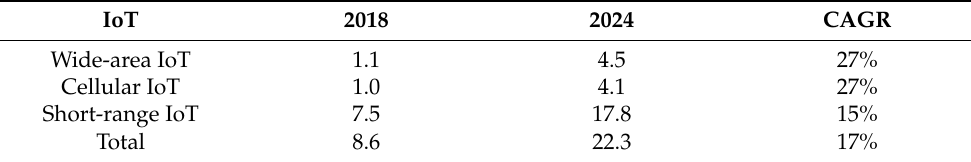
Table 1. All IoT devices are connected to the Internet, as projected by